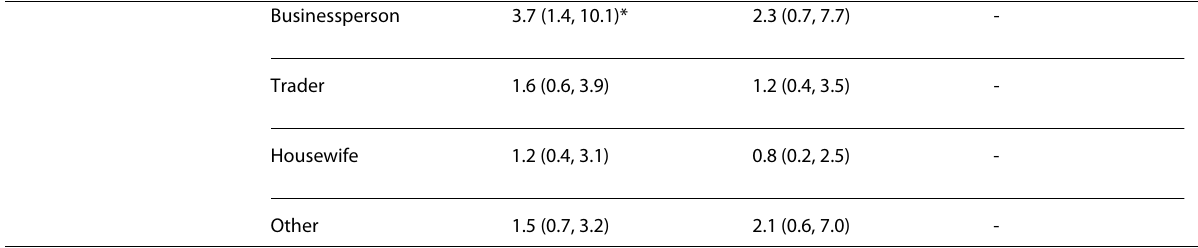
Table 3: Non-antenatal population: Unadjusted and Adjusted ORs of Testing Positive